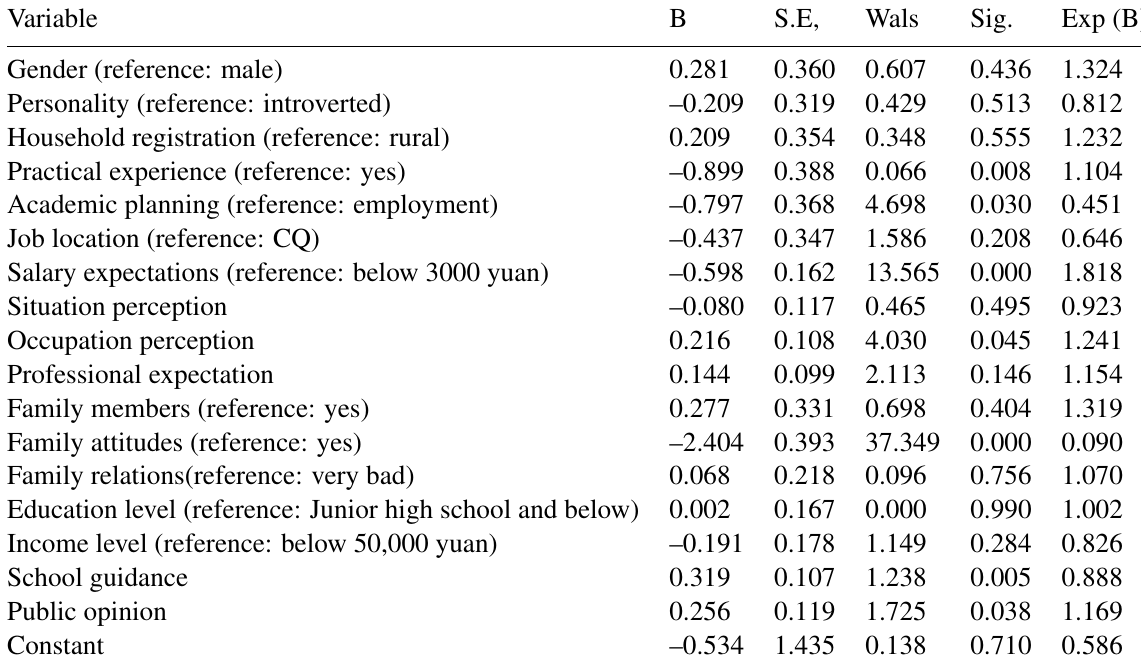
Table 11 Logistic regression